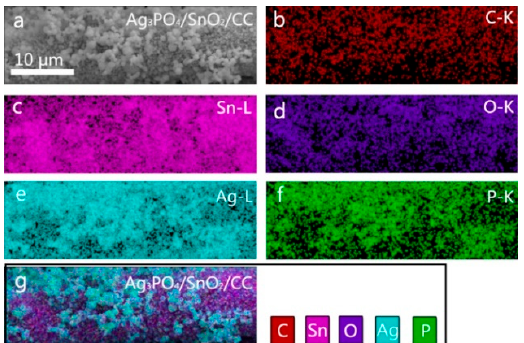
Figure 3. SEM image of Ag 3 PO 4 /SnO 2 /CC ( a ) and the elemental mapping images of C ( b ), Sn ( c ), O ( d ), Ag ( e ), P ( f ) and Ag 3 PO 4 /SnO 2 /CC ( g ).